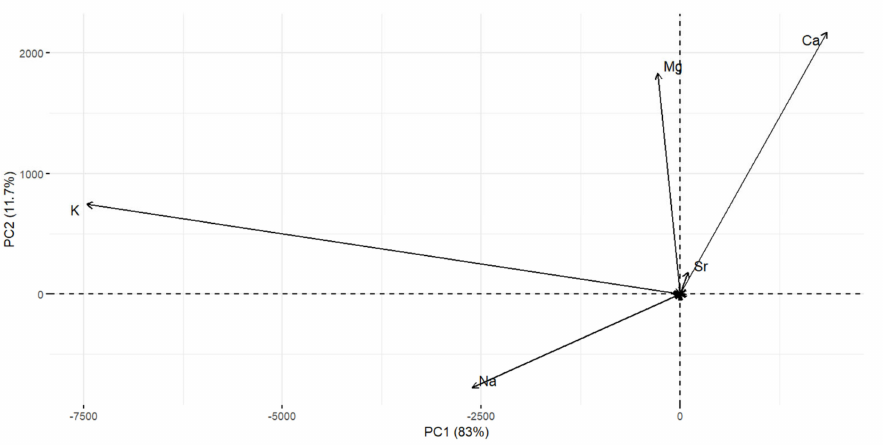
Figure 13. Principal component analysis of elements.